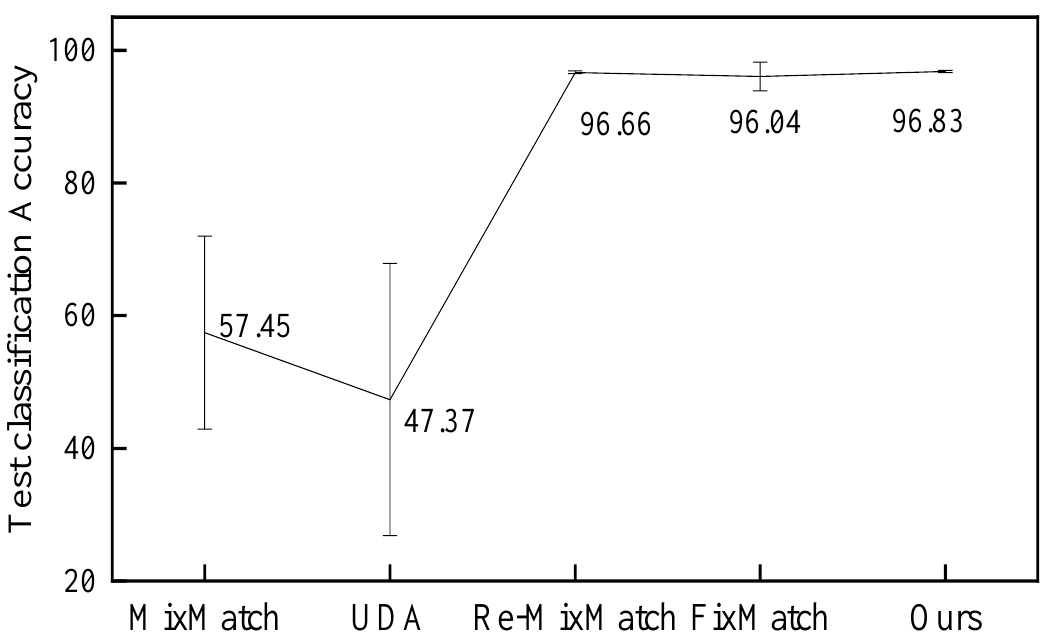
Figure 11. Accuracy of different models trained on the SVHN dataset with 40 labeled samples from the test set.